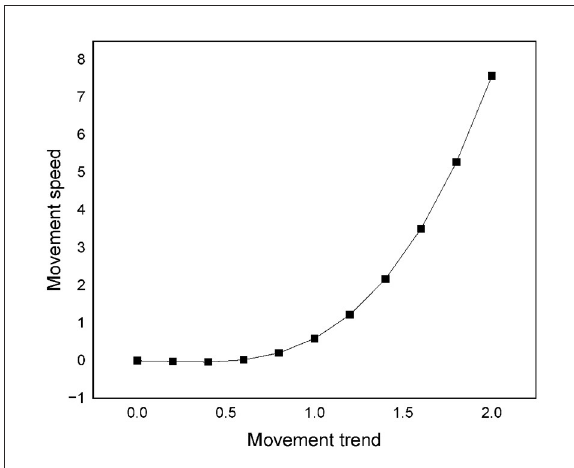
FIGURE3 The potential function simulation of technological system.